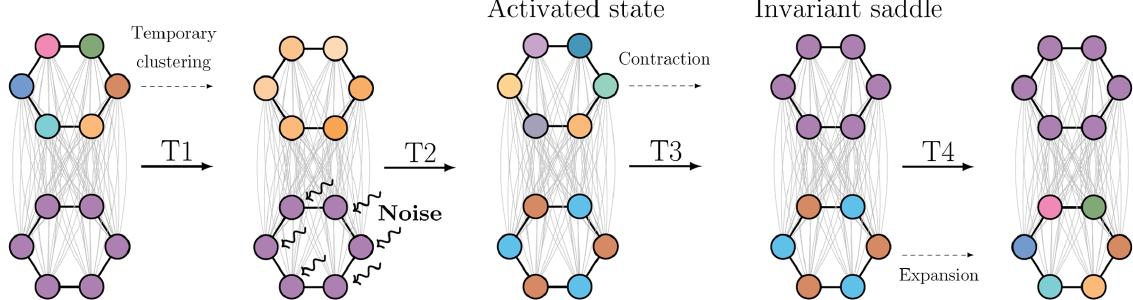
FIG. 4. Dominant transition pathway between the two symmetric subchimeras, which consists of the intermediary stages T1 – T4. Only T2 requires activation from noise, which can be arbitrarily small but not strictly zero; all other transitions follow directly from the deterministic dynamics of Eq. (1). In particular, T3 and T4 follow the stable and unstable manifolds of the invariant saddle, respectively.